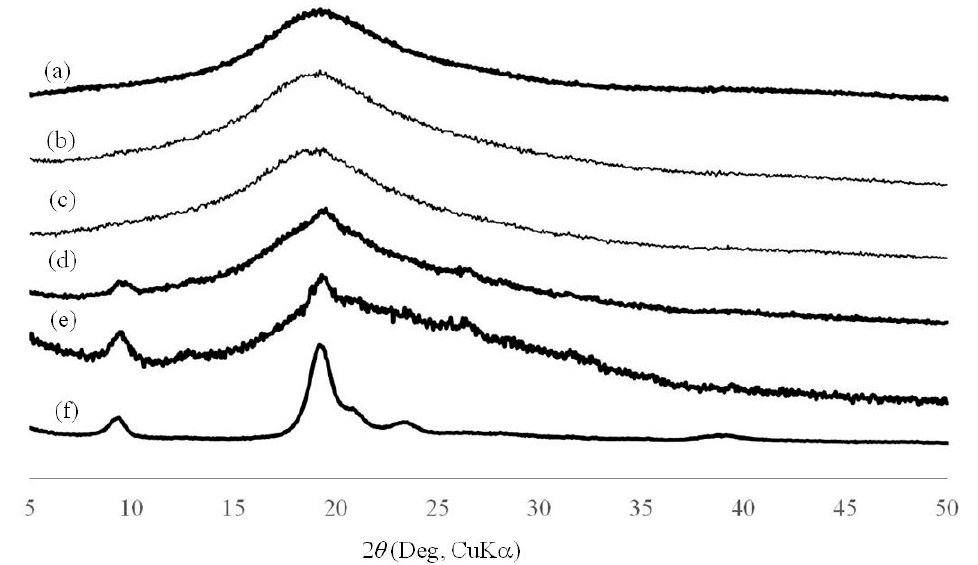
Figure 7. XRD profiles of ( a ) NR; ( b – e ) self-assembled CNF-NR composite porous materials (CNF:NR (weight ratio) = 0.01, 0.02, 0.1, 0.2:1, respectively); and ( f ) self-assembled CNF film.